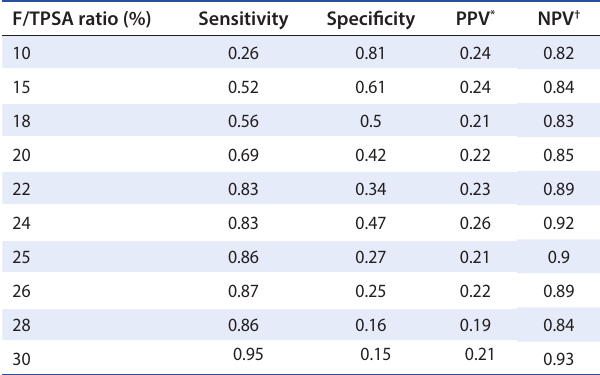
Notes: * PPV: positive predictive value. † NPV: negative predictive value.